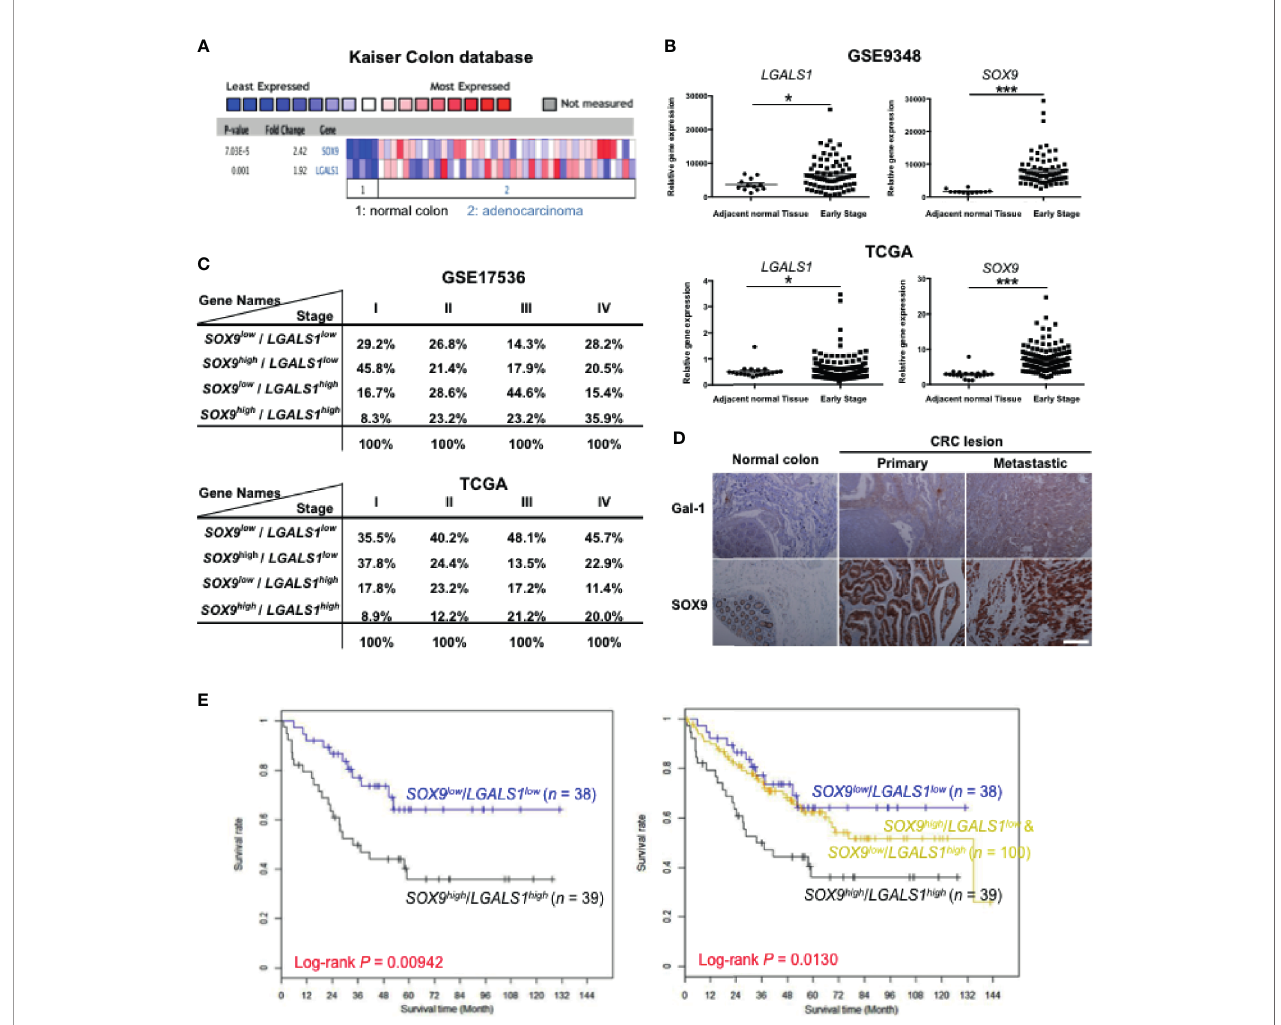
FIGURE 6 | High expression of Gal-1 and SOX9 correlate with clinical CRC outcome. (A) ONCOMINE assessment of the expression levels of LGALS1 and SOX9 in the Kaiser Colon database. (B) Analysis of LGALS1 or SOX9 expression levels in tumor tissue compared to adjacent normal tissue using GSE9348 (top panel) and The Cancer Genome Atlas (TCGA) databases (bottom panel). * p < 0.05 and *** p < 0.005 for early-stage lesions compared to adjacent normal tissue. (C) Analysis of LGALS1 and SOX9 expression levels to the CRC stage using the GSE17536 and TCGA datasets. (D) Immunohistological staining of Gal-1 and SOX9 on CRC tumor samples, which included 40 primary lesions (primary), 10 metastatic lesions (metastatic), and 9 normal colon samples; scale bar, 100 m m. (E) Kaplan-Meier survival curves of four groups of CRC patients as strati fi ed by median expression levels of SOX9 and Gal-1 in tumor tissue: SOX9 low /Gal-1 low , n = 38; SOX9 low /Gal-1 high & SOX9 high /Gal-1 low , n = 100; and SOX9 high /Gal-1 high , n = 39. Survival analyses was performed for two groups: SOX9 high /Gal-1 high versus SOX9 low /Gal-1 low (left-side graph); or for three groups: SOX9 high /Gal-1 high versus SOX9 high /Gal-1 low + SOX9 low /Gal-1 high versus SOX9 low /Gal-1 low (right-side